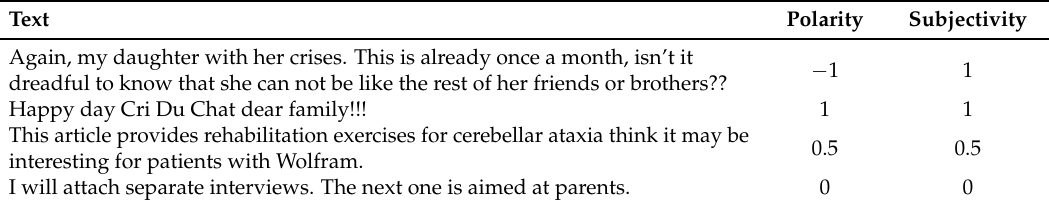
Table 5. Examples of polarity and subjectivity scores.